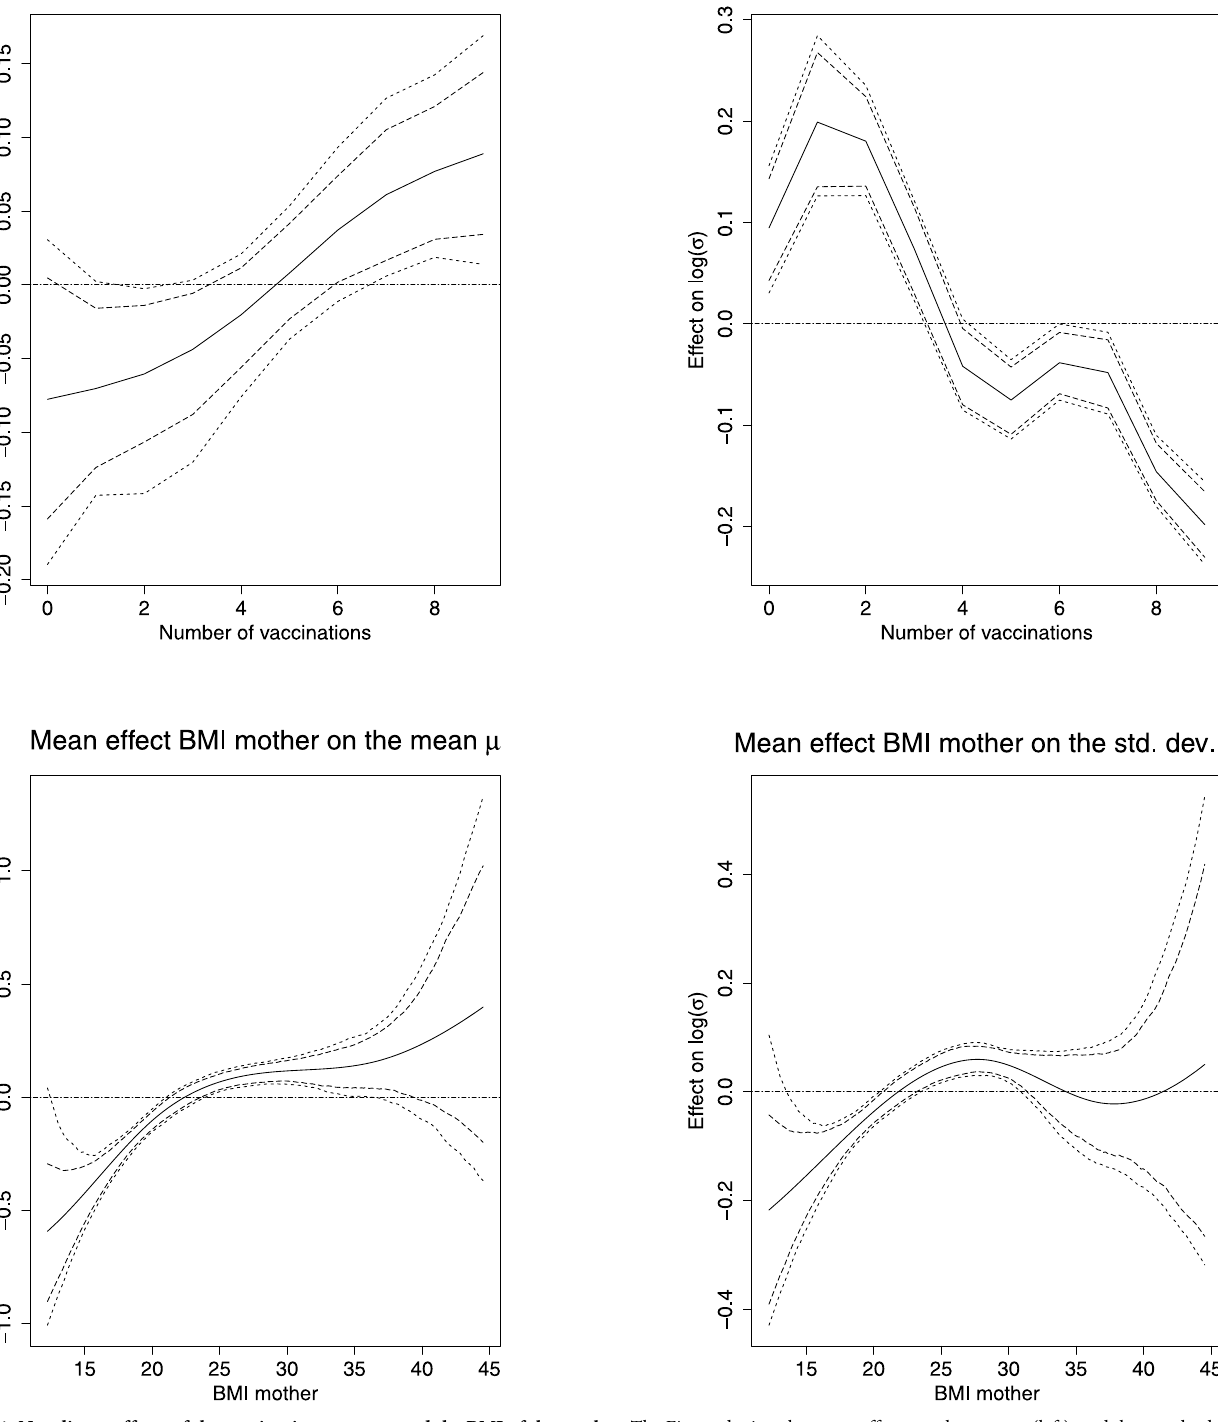
PLOS ONE | https://doi.org/10.1371/journal.pone.0255073 August 4,